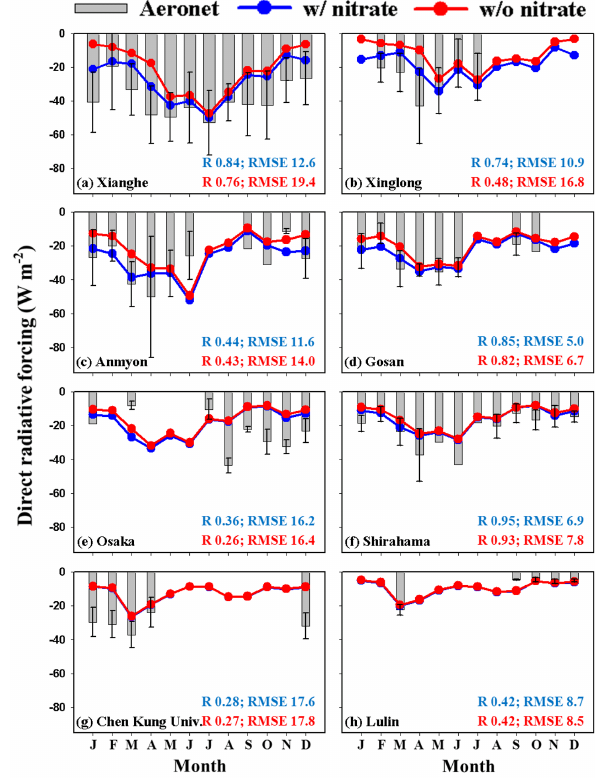
Fig. 12. Same as Fig. 8 but for direct radiative forcing (DRF) by aerosols at eight AERONET sites. Here, the DRF values (blue- and red-dotted lines) were calculated at the top of the atmosphere by the SBDART model. All the comparisons were made under clear-sky